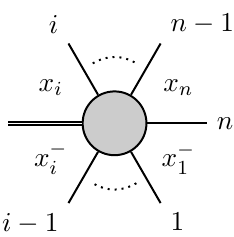
Figure 1. Possible assignments of region momenta in a planar form factor diagram. The double line corresponds to the o(cid:11)-shell leg carrying incoming momentum q . In our notation x (cid:0)